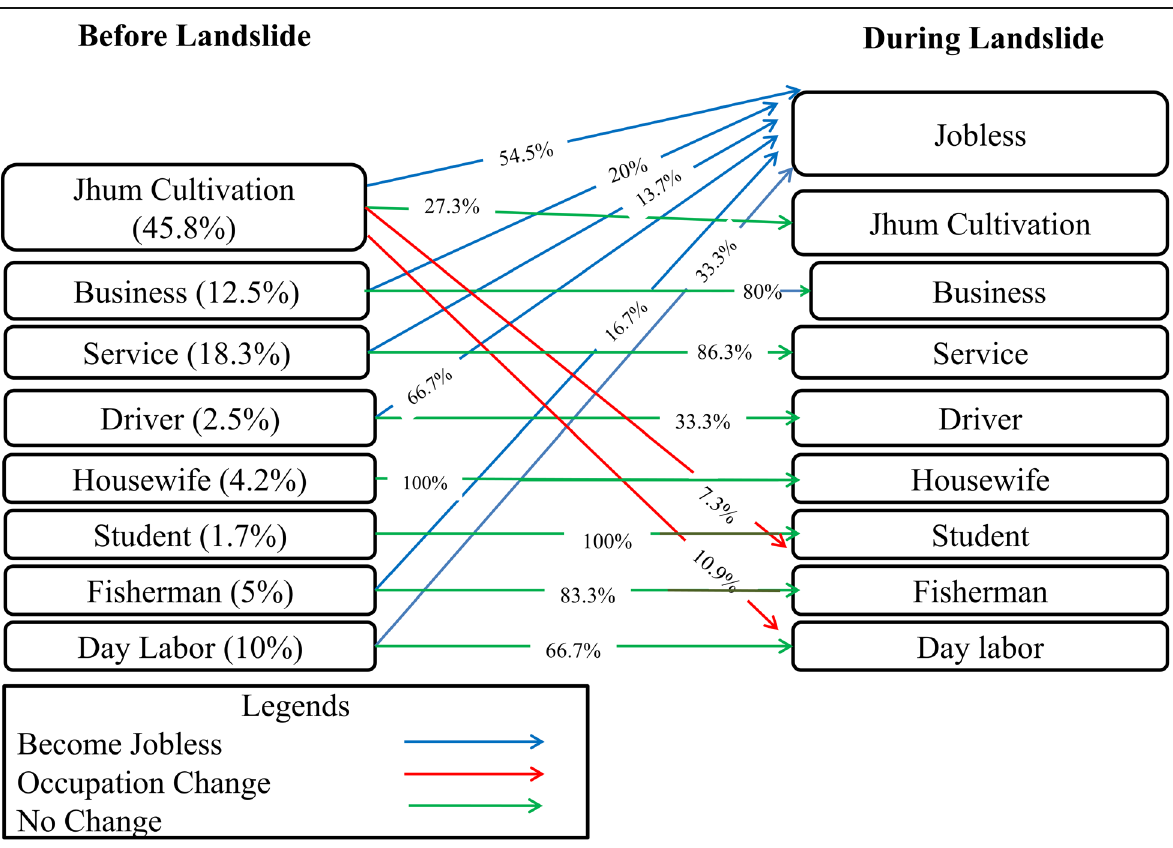
Fig. 7 Change of Occupation of the Respondents After the June 13, 2017 Landslides in three Upazilas of Rangamati District